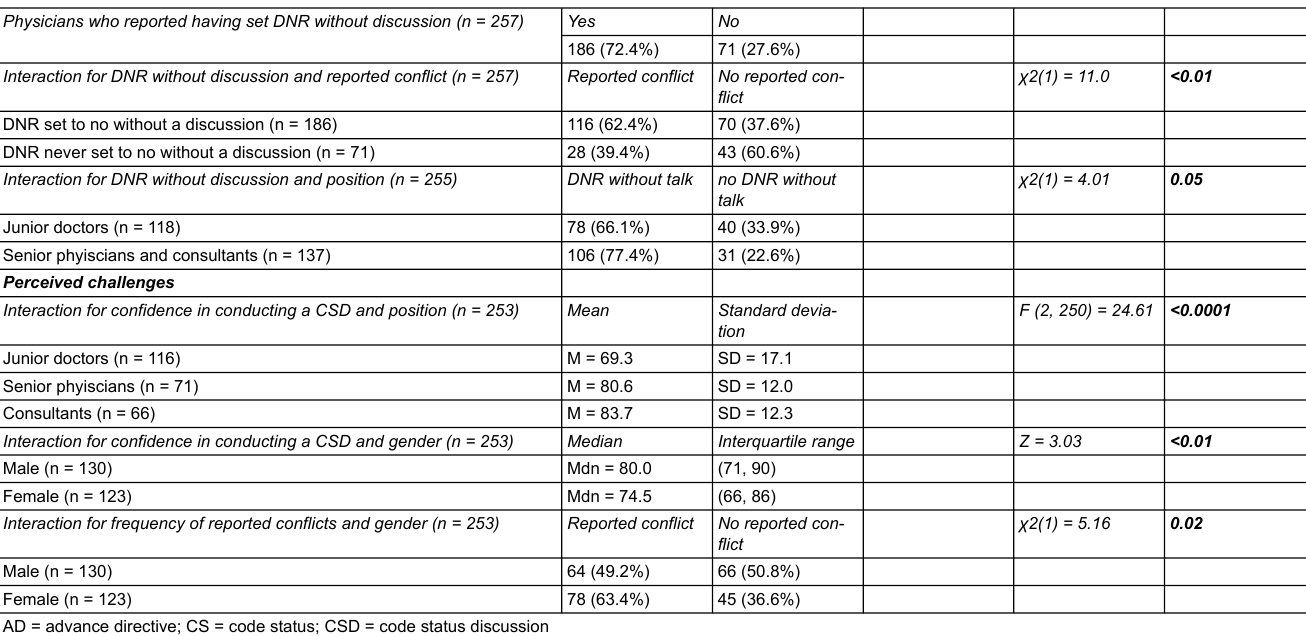
Figure 1a: Box plots with median values of patients’ rating of dif- ferent concerns caused by and satisfaction with communication